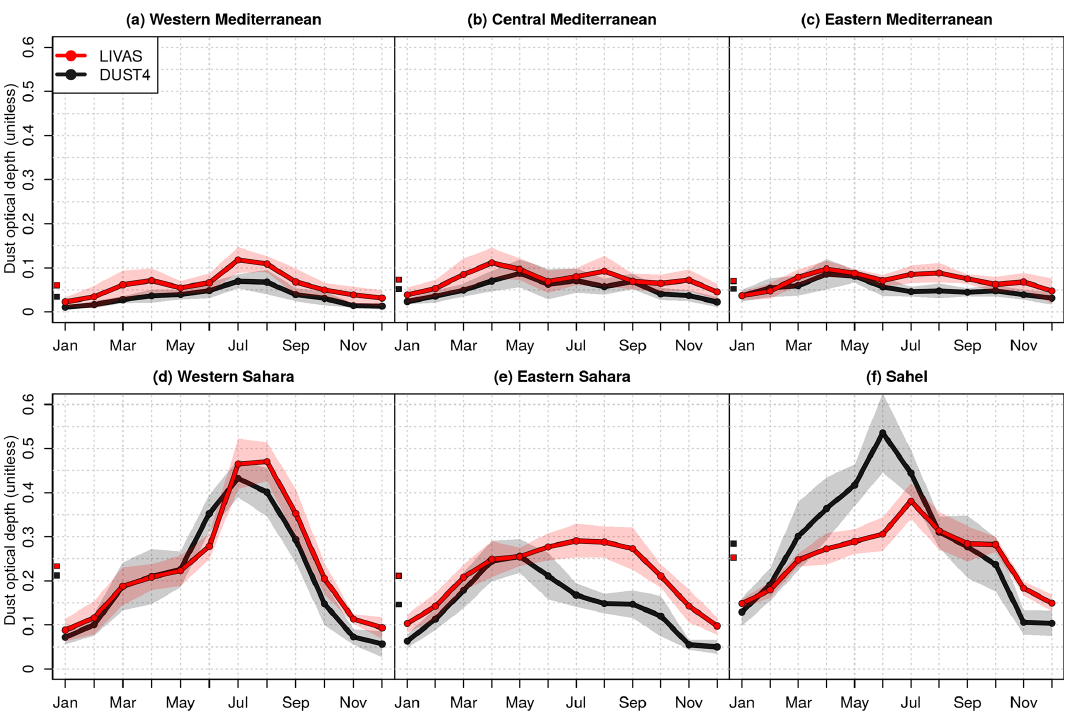
Figure 4. Dust optical depth annual cycle of LIVAS and DUST4 experiment for the period January 2007 to November 2014. Shaded areas display the 95% confidence interval of the